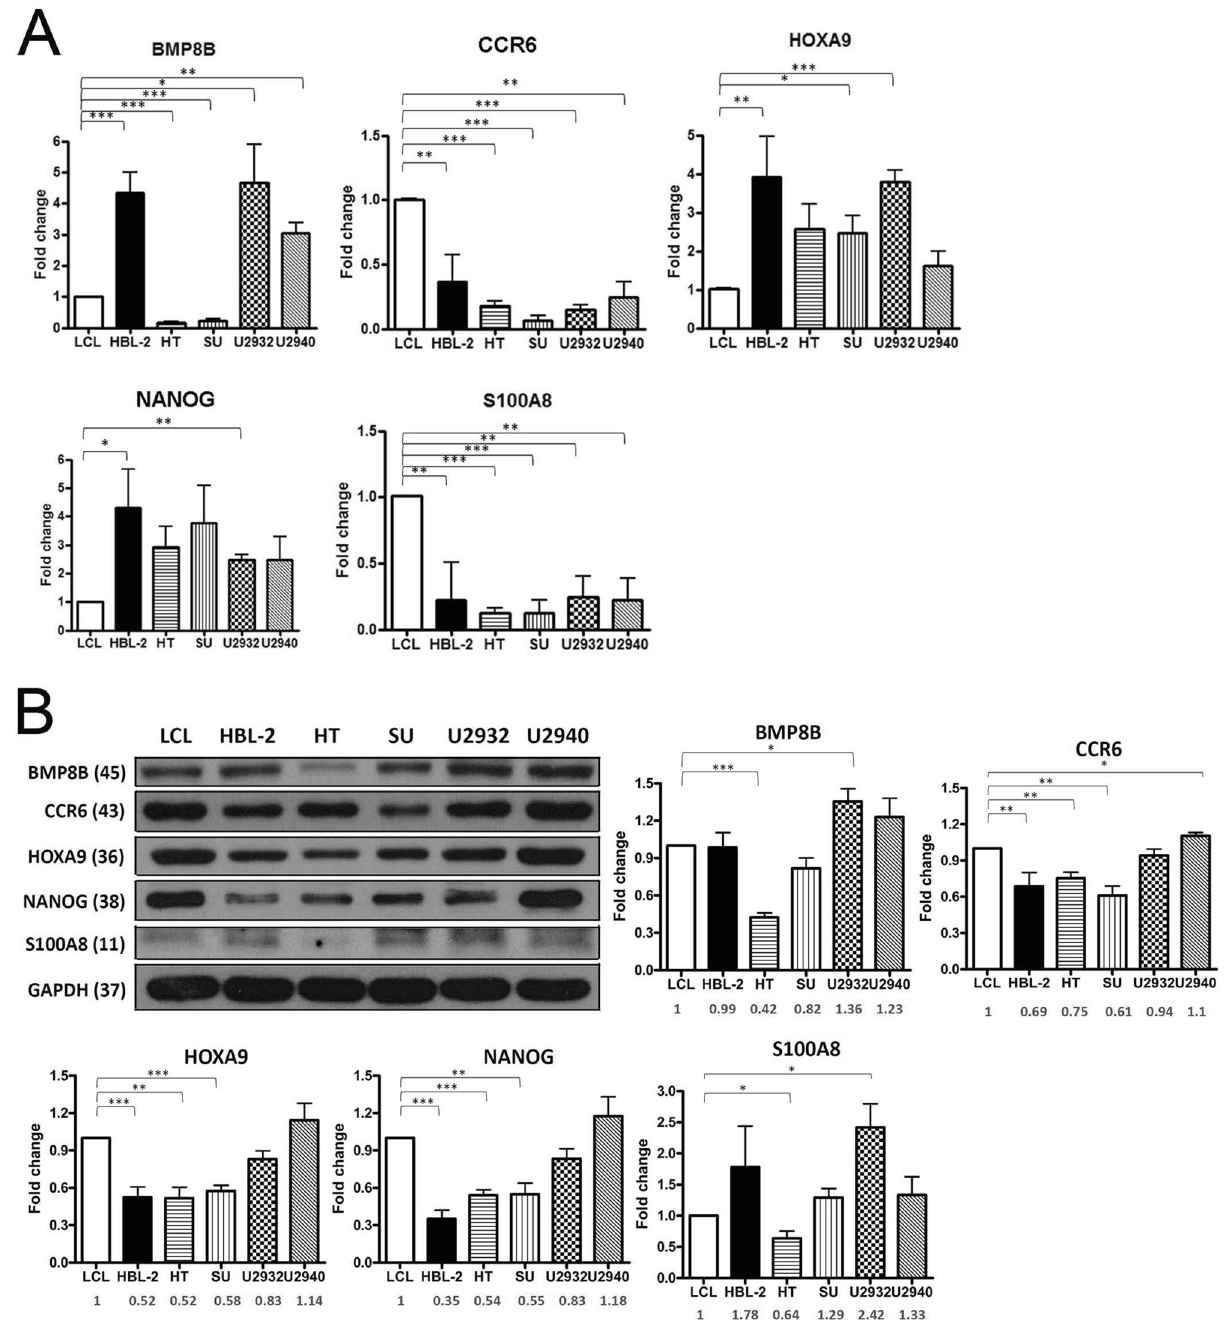
Figure 2. Quantitative PCR and immunoblotting of five candidate gene products in DLBCL and LCL lines. ( A ) Reverse transcriptase and real-time PCR analysis of mRNAs for BMP8A, CCR6, HOXA9, NANOG and S100A8 in LCL and DLBCL (HBL-2, HT, SU-DHL-5, U2932 and U2940) cell lines. Data were normalized by the amount of GAPDH mRNA, expressed relative to the corresponding value for LCL, and are shown as means ± SD from triplicate data. ( B ) After quantification of Western blot intensity, the relative expression levels of each protein are shown with normalization of GAPDH. U2940 cells have the highest expression of the stem cell genes, HOXA9 and NANOG. Molecular weight listed in parenthesis. Error bars represent the standard error of the mean of three independent experiments. * p < 0.05, ** p < 0.01, *** p < 0.001, Student t